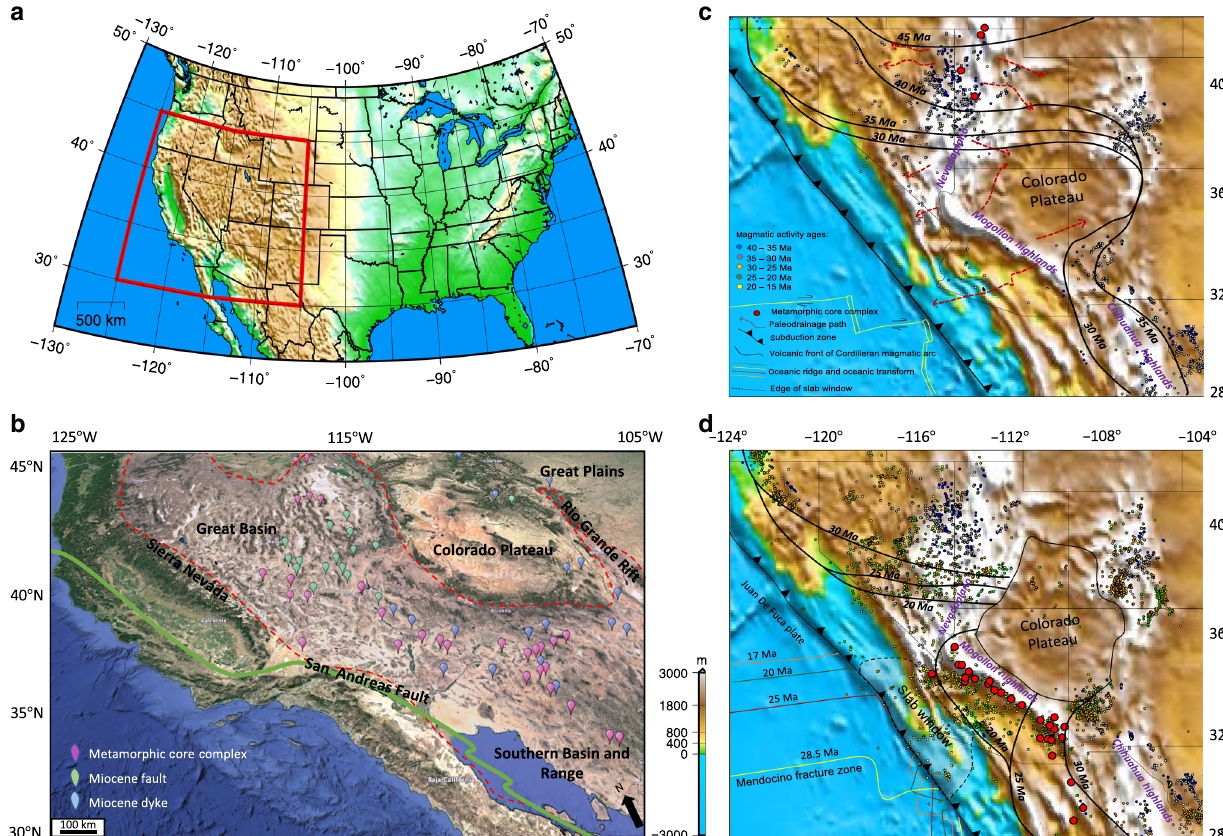
Fig. 1 Northeast Paci fi c and southwestern North American plate tectonic evolution since the Oligocene. a Map of surface elevation in southwestern North America and the location of Basin and Range Province. b Satellite image of southwestern North America showing the location of the Basin and Range Province, Colorado Plateau, Rio Grande Rift, San Andreas Fault System, along with present-day positions of MCCs, and Miocene faults and dykes. c Map of paleo-elevation model of southwestern North America at 31 Ma from Bahadori et al. 8 showing boundary condition changes, slab rollback development (black contours), MCCs, and ignimbrite fl are up from Dickinson 1 as well as paleo-drainage patterns (dashed red arrows) from Henry et al. 26 ; d same as “ c ” but at 27 Ma. Panels “ c ” and “ d ” show the reconstructed positions of magmatism and MCCs at 31 and 27 Ma,